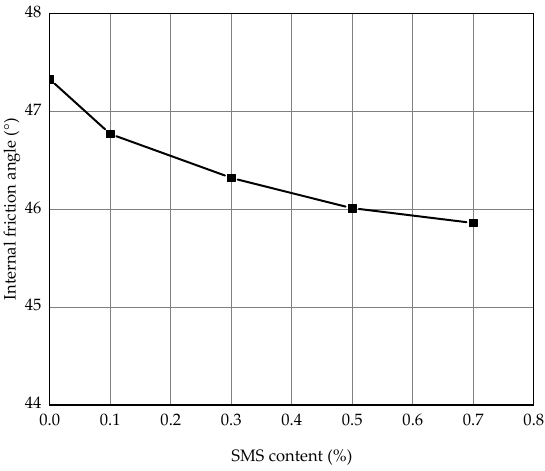
Figure 5. Variation of internal friction angle with SMS content.